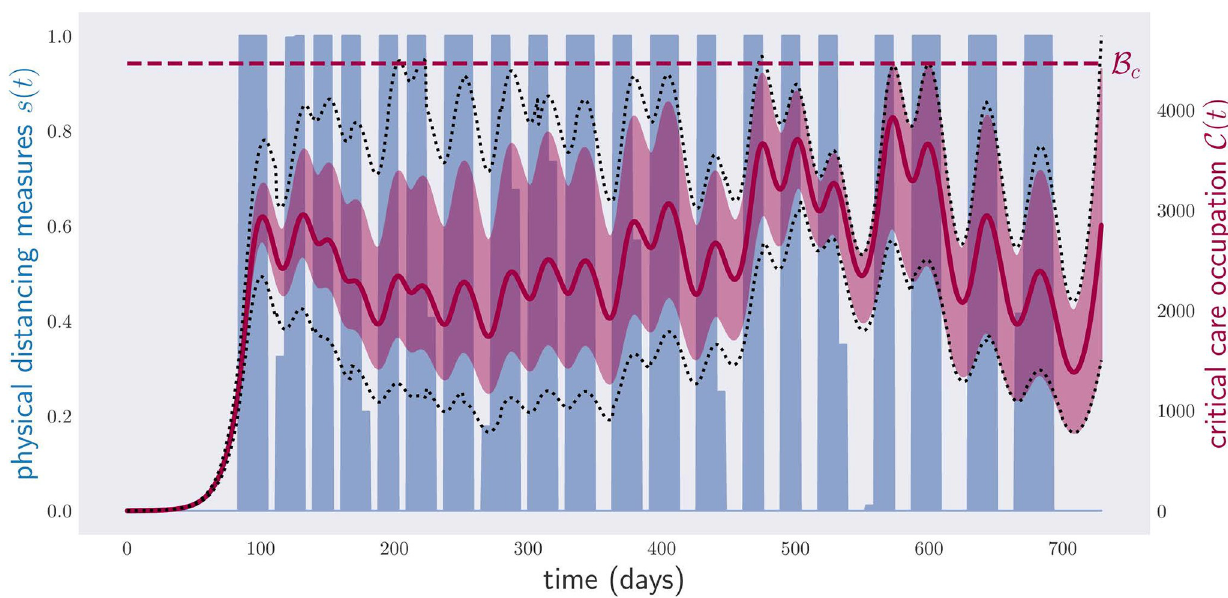
Fig 12. Occupation of critical care beds (red) and physical distancing measures (blue) for a period of two years under random parameters and monthly noise decrease. The disease control policy was optimized to respect the condition in Eq (2), i.e., critical care capacity not exceeded, starting with the parameter region N and with a monthly noise decrease of 1 ffiffi p , i.e., in the k -th month the noise is equal to 0 : 25 = 0 : 25 k the range of critical care occupations observed in a sample of 1000 model parameters in a sequence of shrinking regions N month k the red region is obtained by evolving, from the initial time to month k (included), 1000 different models with parameters sampled from the ffiffi region N p . The final plot is obtained by joining the plots for each month k . The inner region in red depicts the range of critical care occupations 0 : 25 = k corresponding to the uncertainty in the final month, i.e., obtained with 1000 models with parameters sampled in N critical care occupation, obtained by joining the average of the simulations with decreased uncertainty for each month k . Despite the initial uncertainty on the parameters ν of the disease model, the final lockdown time is much lower, due to monthly revisions of the original policy plan.